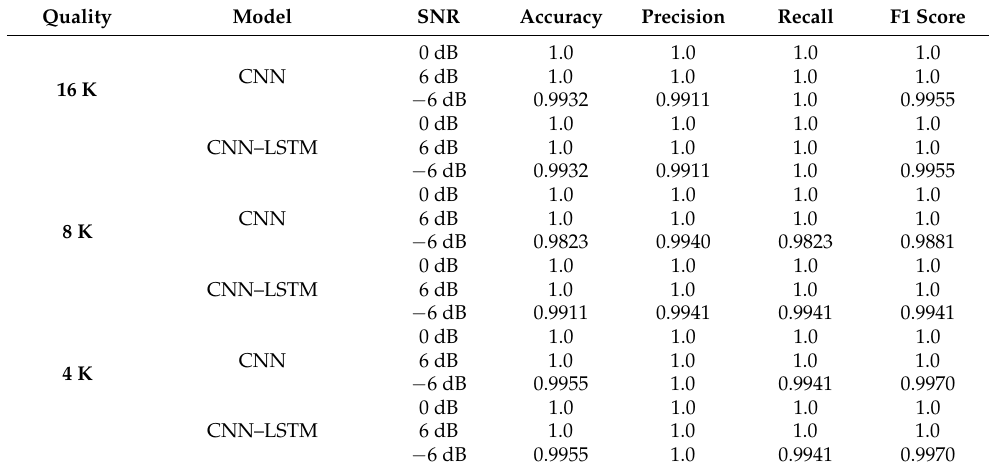
Table 5. Result of training on the CNN and CNN–LSTM models by performing the STFT for slider data.